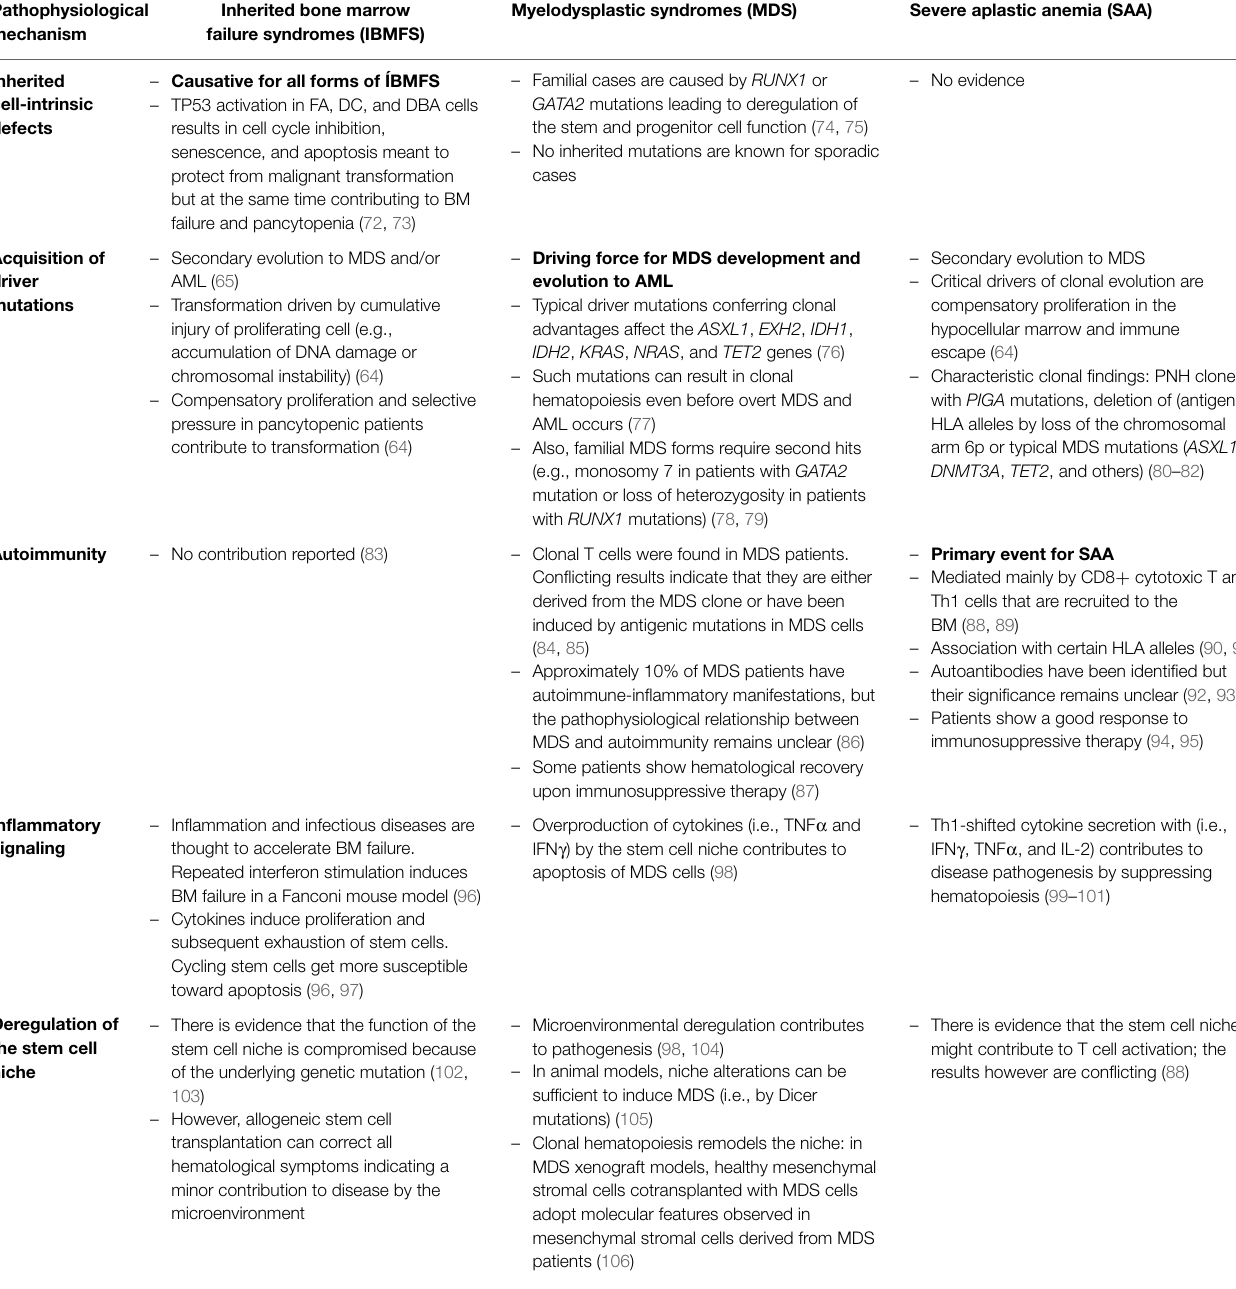
TABLE 3 | The different pathophysiological mechanisms and their relative contributions to inherited bone marrow failure syndromes, severe aplastic anemia, and myelodysplastic syndromes